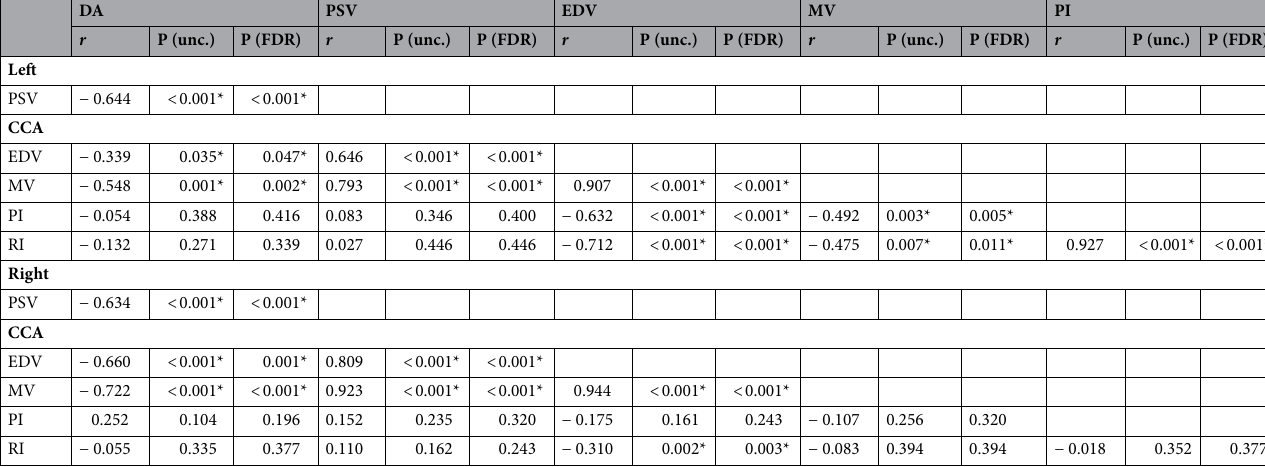
Table 1. Correlation matrix within sided ultrasonographic parameters. DA diameter of artery, CCA common carotid arteries, EDV end-diastolic velocity, MV mean velocity, P (unc.) uncorrected p values of bootstrapping statistics, PI pulsatility index, r average correlation coefficient across bootstrap iterations, PSV peak systolic flow velocity, RI resistance index, P (FDR) p values of bootstrapping statistics with FDR-correction. *A statistically significant correlation after FDR correction.